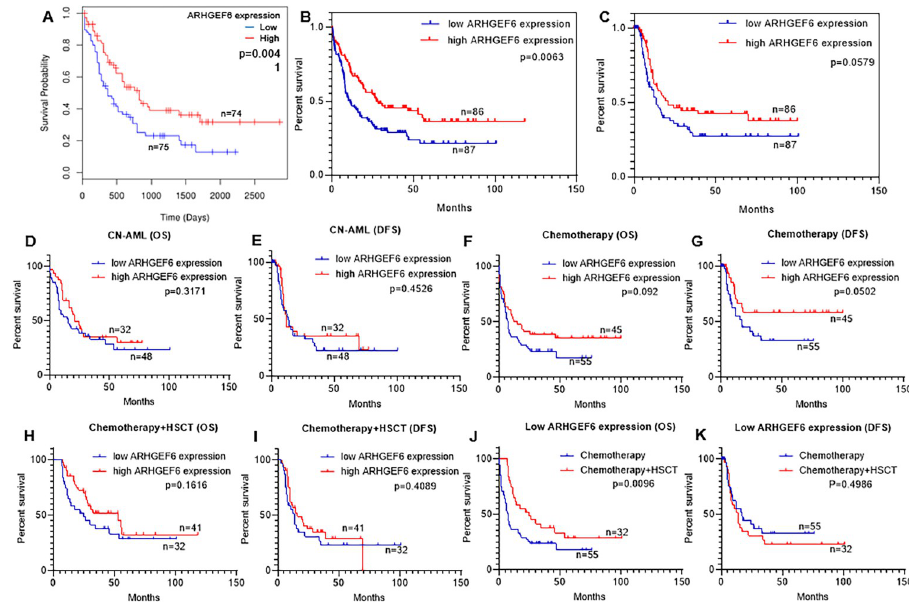
Fig 2. Correlation between AML patient survival and ARHGEF6 expression with different factors. (A) The prognostic value between ARHGEF6 low and ARHGEF6 high group using the LinkedOmics database. (B) OS and (C) DFS in AML patients with different ARHGEF6 expressions. (D) OS and (E) DFS in CN-AML patients with different ARHGEF6 expressions. (F) OS and (G) DFS of ARHGEF6 low and ARHGEF6 high patients treated with chemotherapy. (H) OS and (I) DFS of ARHGEF6 low and ARHGEF6 high patients undergoing chemotherapy + auto/allo-HSCT. (J) OS and (K) DFS of patients treated WOW auto/allo-HSCT in the ARHGEF6 low group.